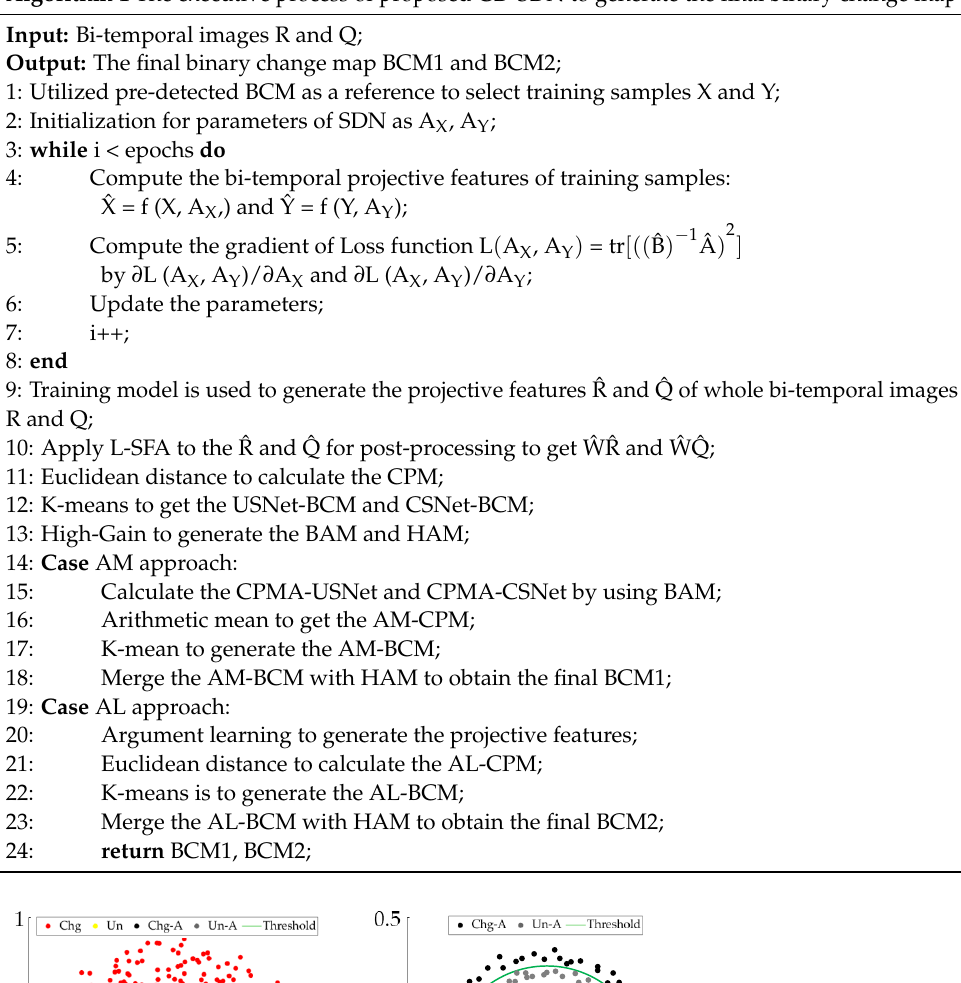
Algorithm 1 The executive process of proposed CD-SDN to generate the final binary change map